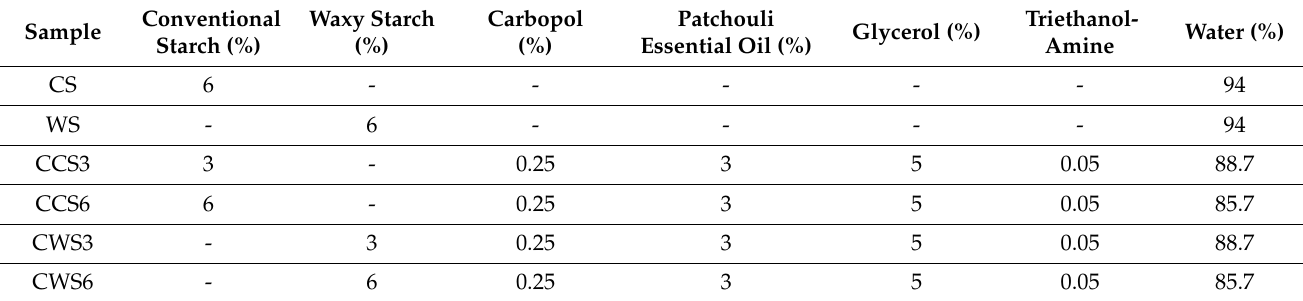
Table 2. Mixture design and chemical composition of hydrogel